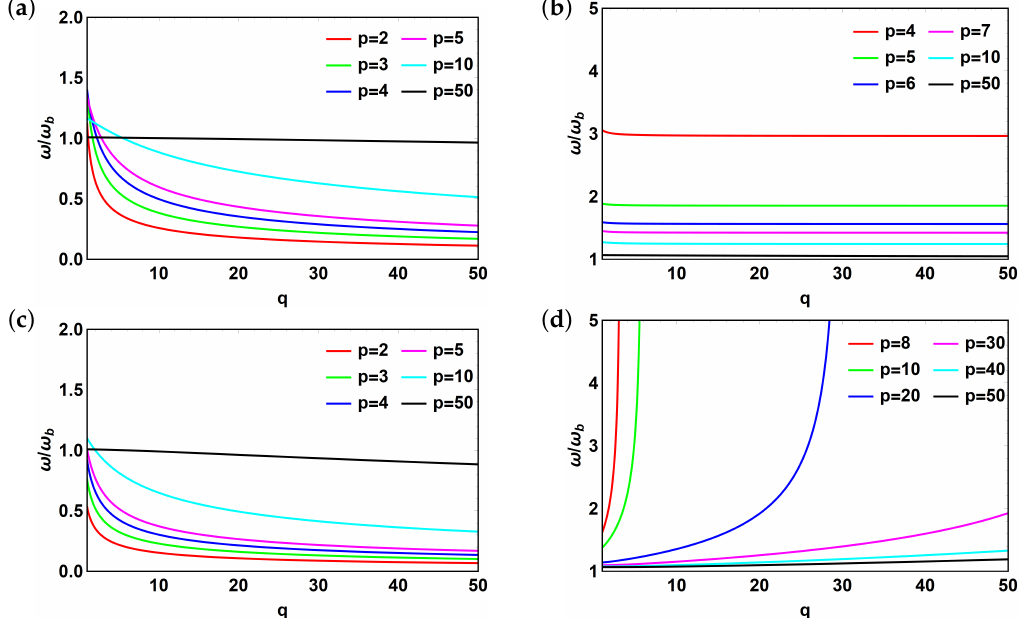
Figure 9. Normalized frequency as a function of q (distance between bubble center and interface) for metascreen ( a ) w/2 interfaces and w/o reflector, “positive” branch, kh (cid:28) 1; ( b ) w/2 interfaces and w/o reflector, “negative” branch, kh (cid:28) 1; ( c ) w/2 interfaces and w/reflector ( r 0 = 0.5), “positive” branch, kh (cid:28) 1; ( d ) w/2 interfaces and w/reflector ( r 0 = 0.5), “negative” branch, kh (cid:28) 1.